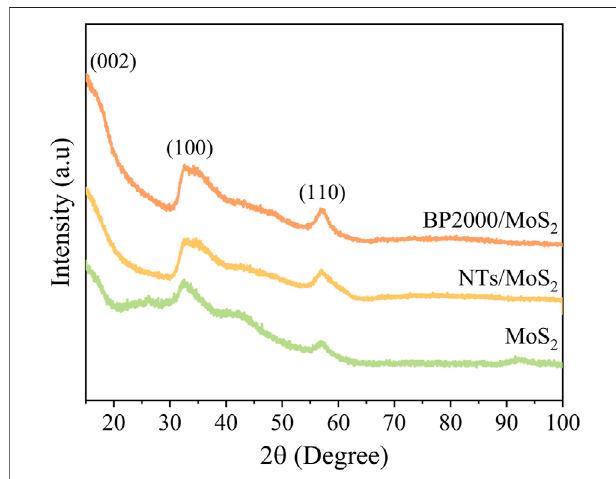
FIGURE 6 | X-ray diffractograms for different materials.